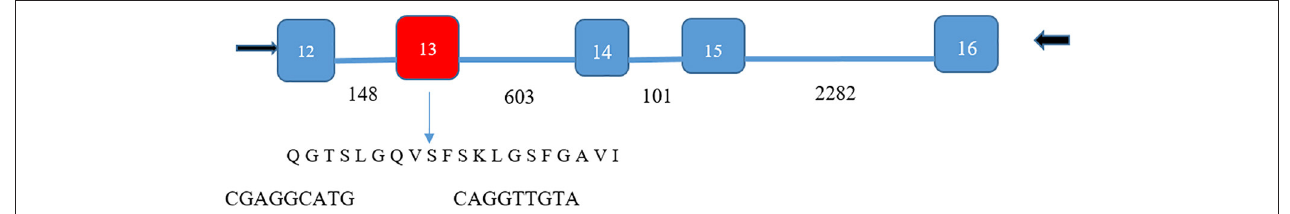
FIGURE 3 | Isoform identification of lipocalin-interacting membrane receptor in ocular surface epithelium. PCR products of 499 and 559 base pairs spanned five exons (numbers shown in white) for the lipocalin-interacting membrane protein. Number of bases in the introns are shown by black numbers. The 60-base pair deletion in exon 13 (red) was verified by the sequencing of the 499 base pair product (DNA sequence cga ggc atg –cag gtt gta bridging the missing sequence). The missing 60-base pair sequence corresponds to amino acids missing from isoform 3, Q6UX01-3, an alternative splice variant (https://www.uniprot.org/uniprot/ Q6UX01). This translates to the transmembrane helical segment of the protein sequence shown. The 559-base pair product contained the missing